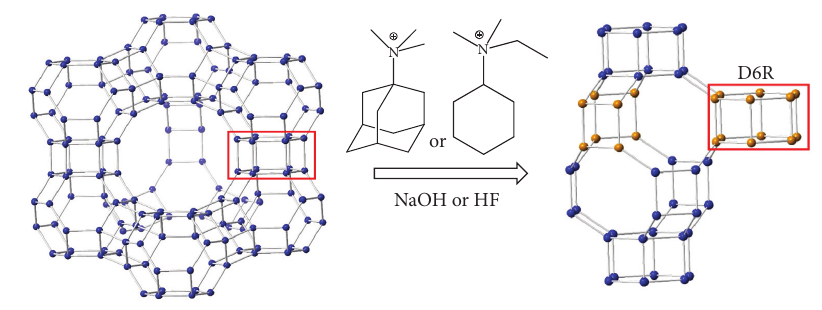
Figure 1: A schematic view of faujasite (left) framework and its transformation into chabazite (right) zeolite under hydroxide and fluoride media. Oxygen atoms were omitted for clarity. The double 6-rings (D6Rs) of faujasite and chabazite zeolites were